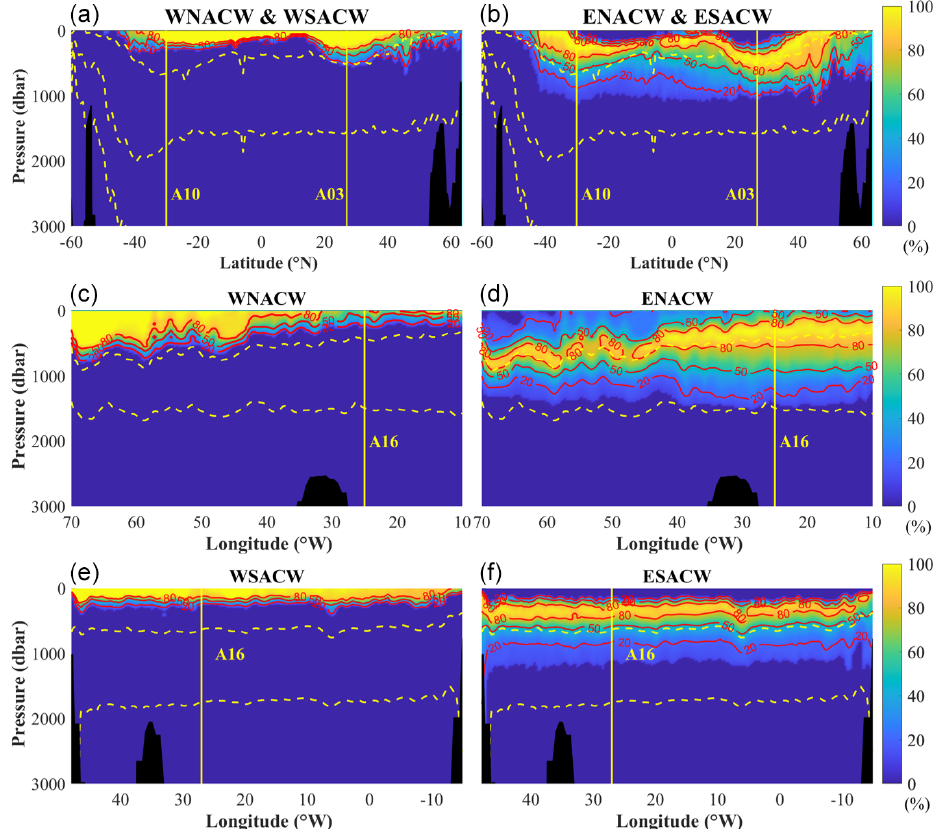
Figure 9. Distribution of central water masses based on A16 (a, b) , A03 (c, d) , and A10 (e, f) sections for the top 3000m depth. The contour lines show fractions of 20%, 50% and 80%, yellow vertical lines show cross overs with other sections, and dashed yellow lines show vertical boundaries of layers (neutral density at 27.10, 27.90 and 28.10kgm − 3